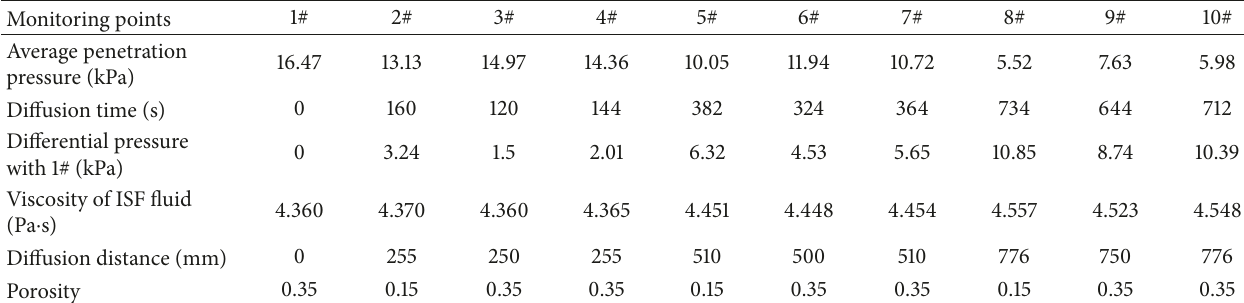
Table 3: Penetration pressure and diffusion time of the monitoring points.